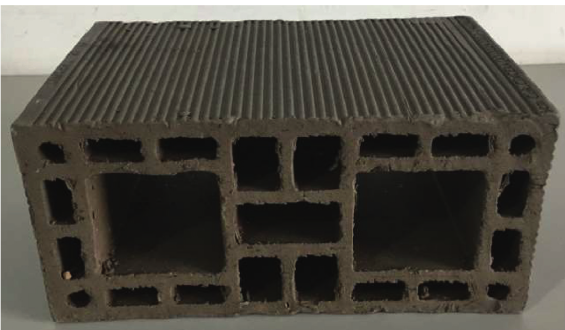
Figure 3: Example of the ceramic brick